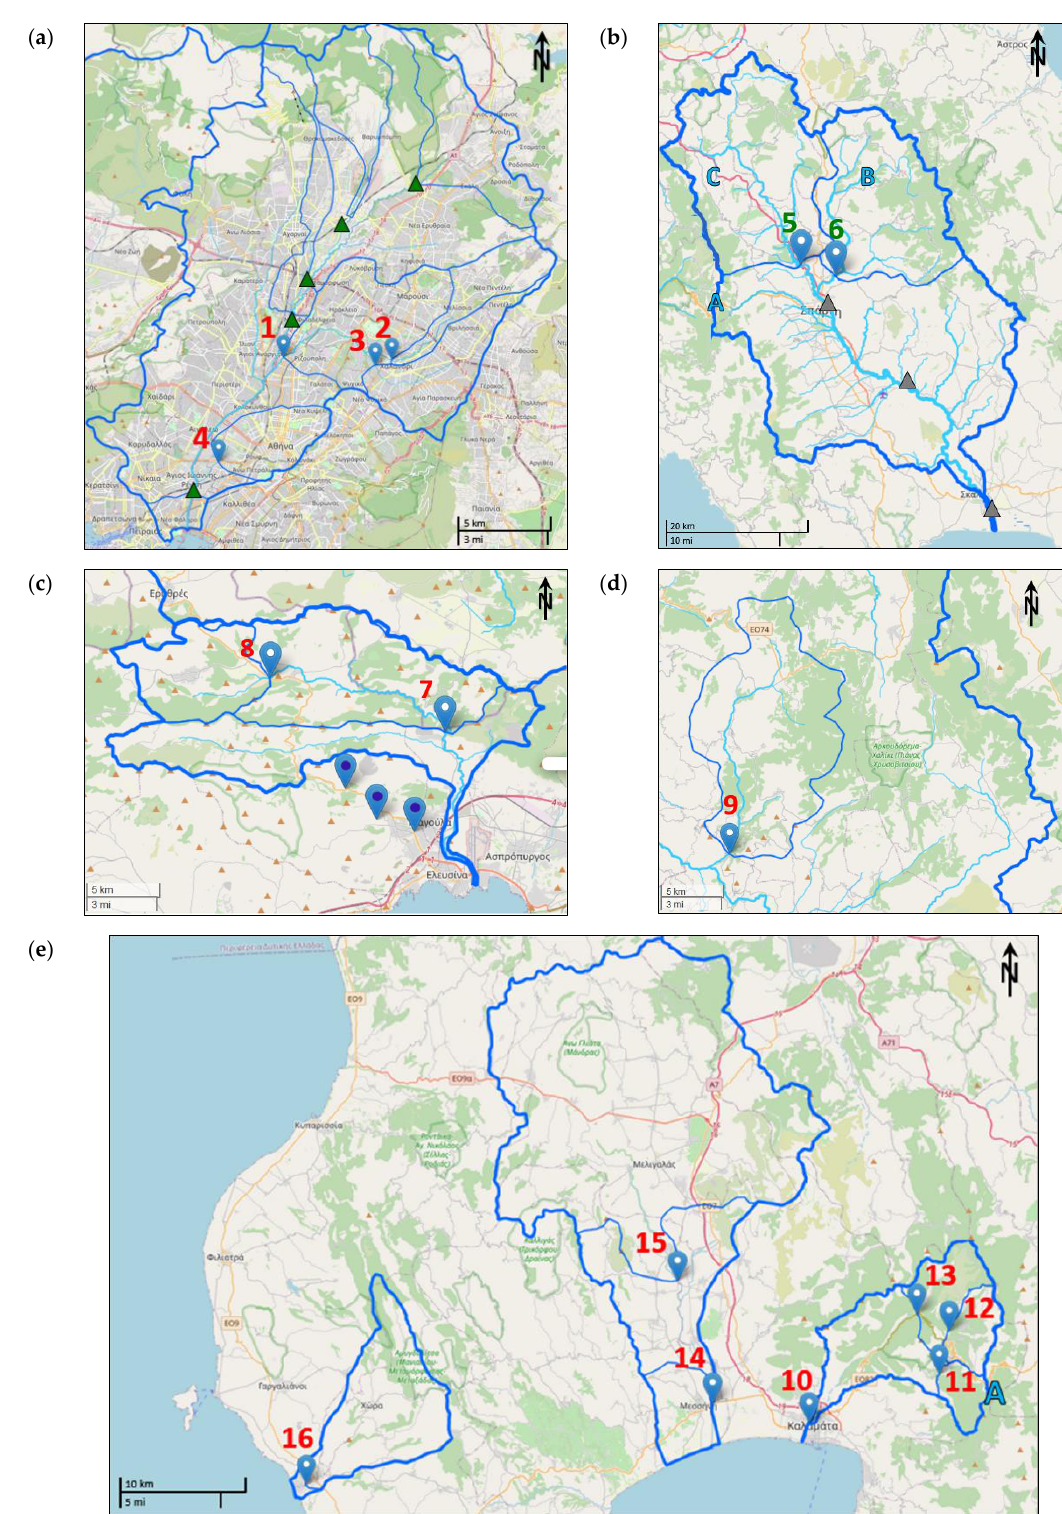
Figure 2. HYDRONET —red numerals indicate stations, see Table 1, and dark blue lines basin borders: ( a ) Kifissos river basin, Attica, ( b ) Evrotas river basin, Laconia, ( c ) Sarantapotamos river basin, Attica/Boeotia, ( d ) Loussios sub-basin of Alpheios River, Arcadia, ( e ) Selas (west), Pamissos (centre), and Nedon (east) river basins, Messinia. Letters in ( b , e ) indicate rain gauges; triangles in ( a , b ) indicate stations of partners in OpenHi.net; and stations without numbers in ( c ) belong to NOA but are not part of HYDRONET .